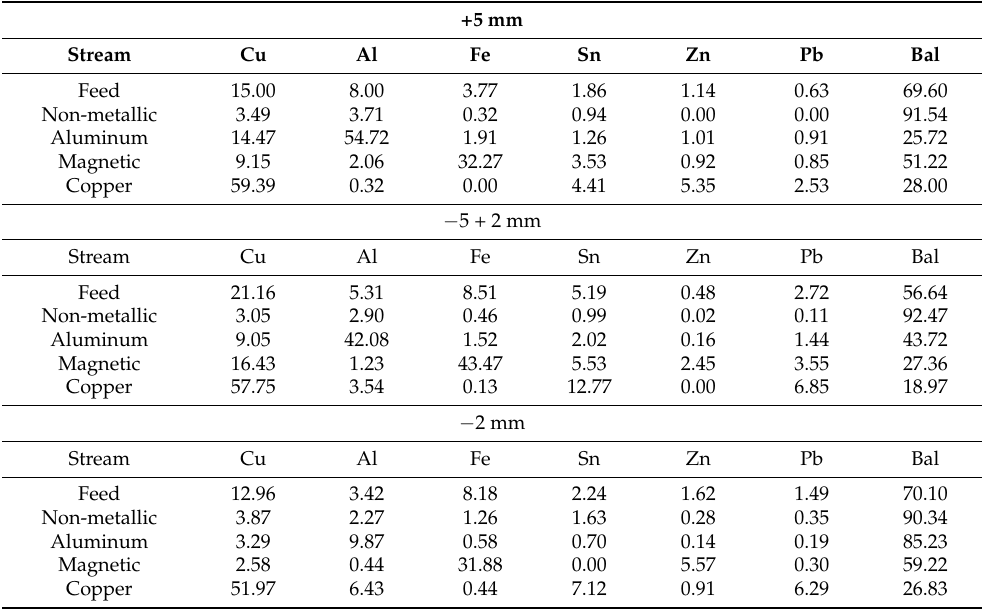
Table 4. Content (mass%) of the main metals in the feed and the concentrate streams. The Bal (balance) class includes minor metals (concentration below 1%), trace metals, and non-metallic